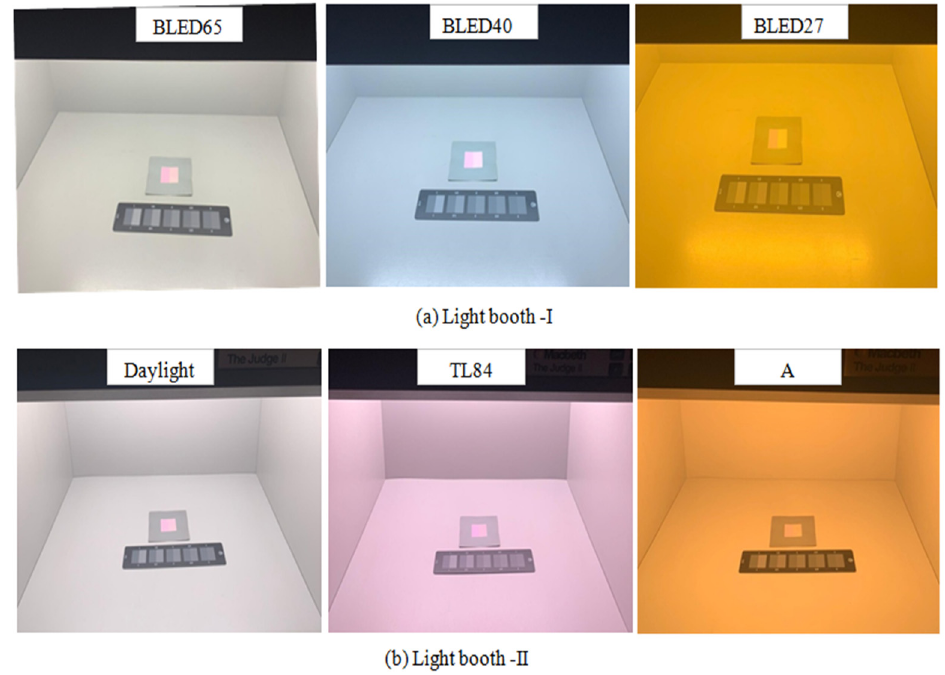
Figure 4. Viewing condition for color difference experiment under two lighting booths.